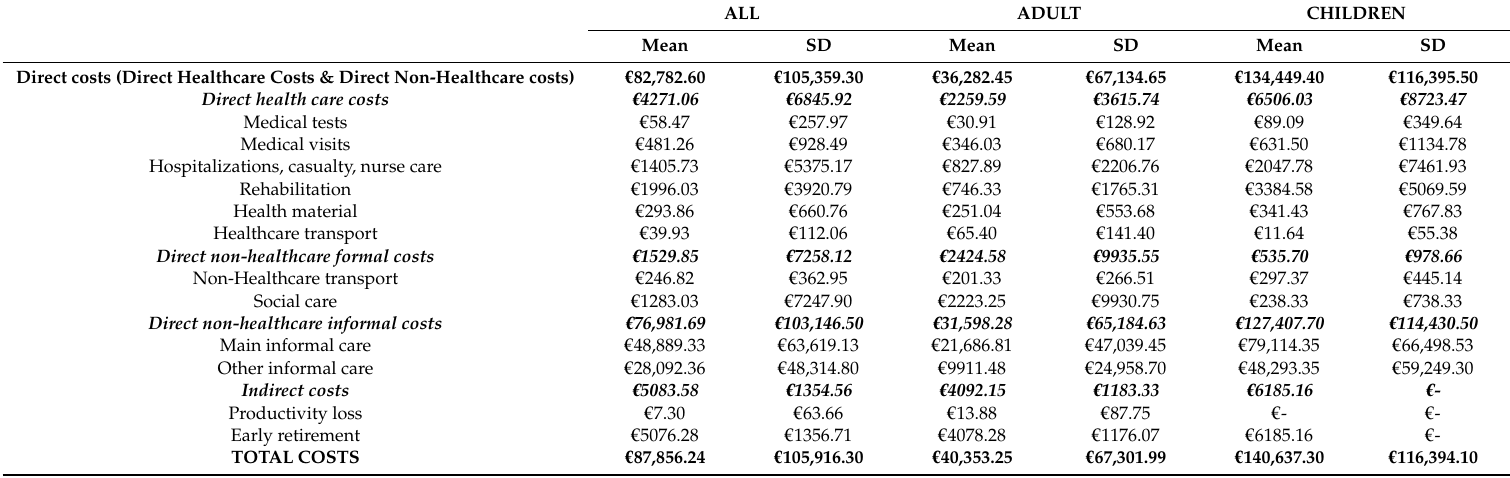
Table 5. Average annual costs per patient with Cri du Chat syndrome—All, adults and children (2017, € ). ALL ADULT CHILDREN Mean SD Mean SD Mean